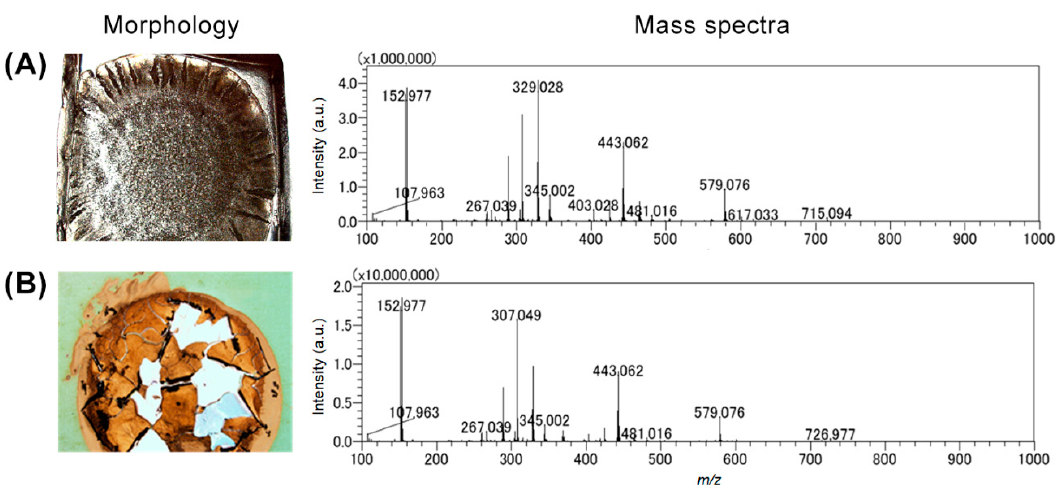
Figure 2. Morphology of modified agar-based biofilms and the mass spectra obtained with ( A ) and without biofilm processing ( B ).